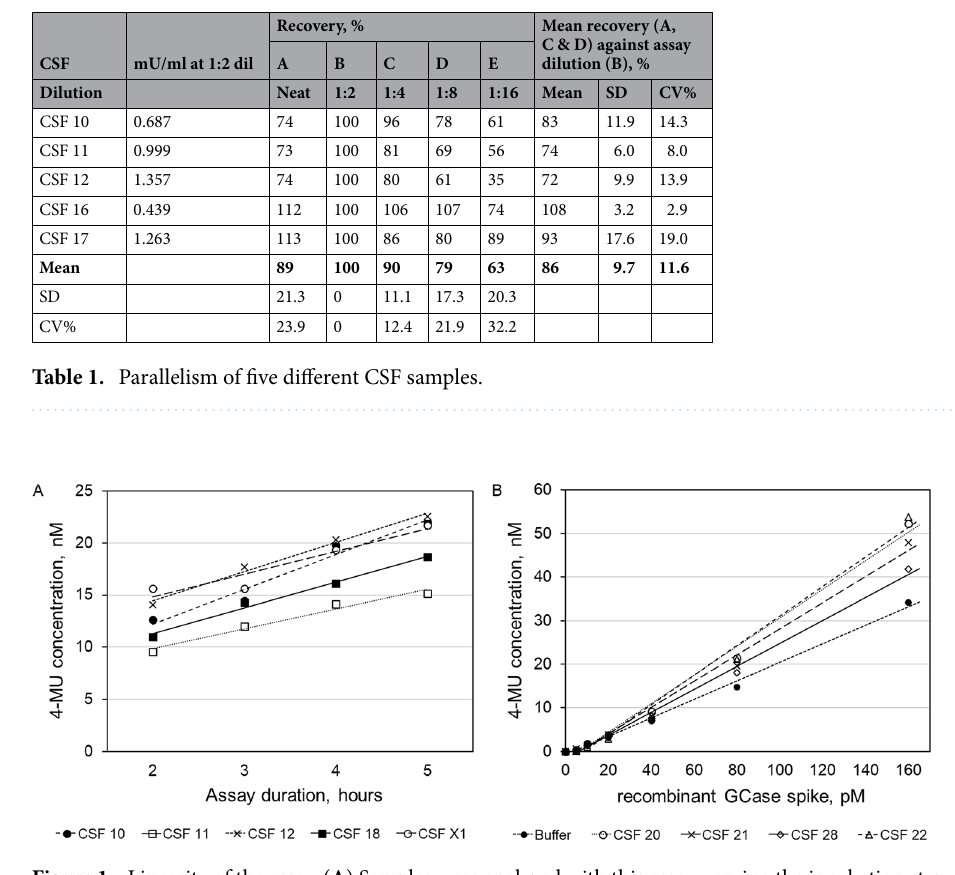
Figure 1. Linearity of the assay. ( A ) Samples were analyzed with this assay, varying the incubation step at 37 °C from 2 to 5 h. Linear regression R 2 varied from 0.899 to 0.988. ( B ) Samples were spiked with recombinant GCase ranging from 5 to 160 pM. Linear Regression R 2 varied from 0.986 to